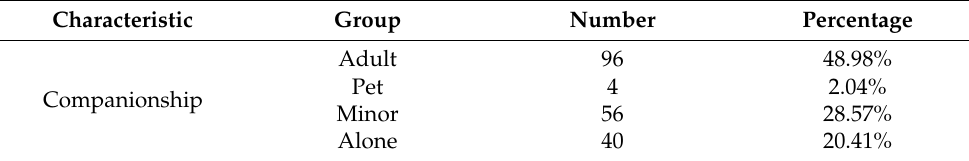
Table 2. Descriptive statistics of the companionship patterns.